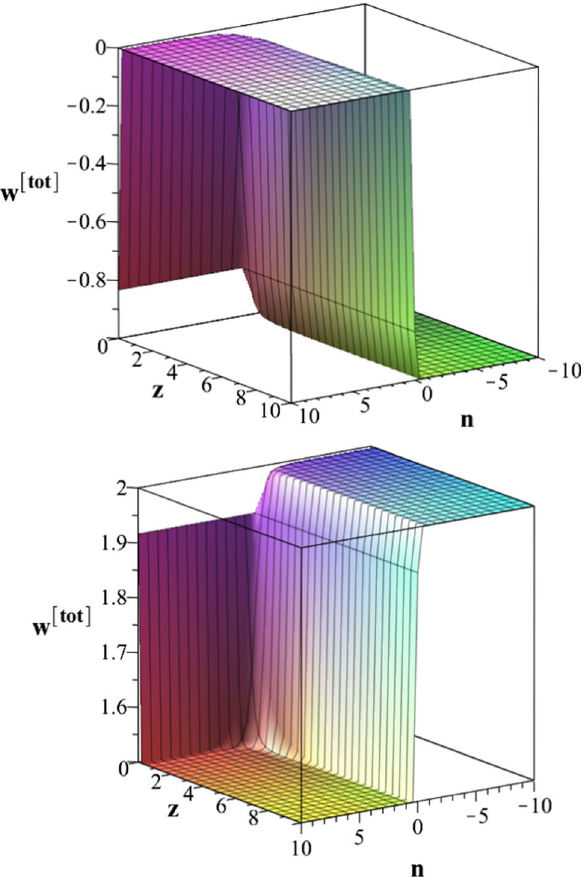
Fig. 1 The plot of the total state parameter with assumptions ˜ (cid:12) ( 0 ) m /(cid:12) ( 0 ) V (cid:7) 3 / 7, M Pl = 1 and, regardless of units, φ 0 = β Besides, the top and bottom diagrams have been plotted with β = 3 . 7 × 10 2 and β = 1, respectively